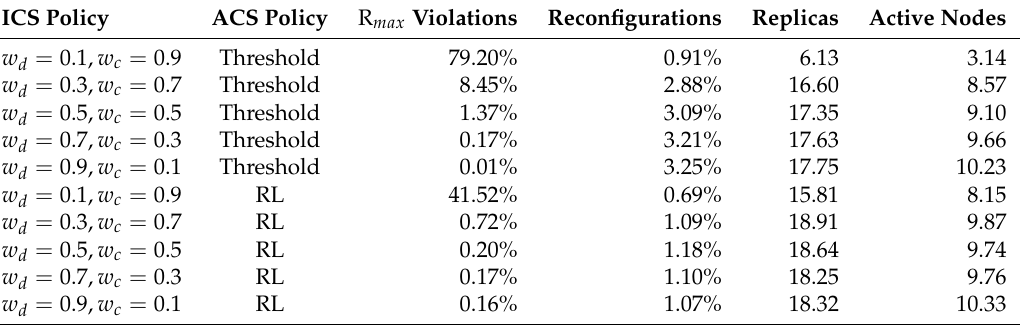
Table 2. Results with different objectives for our RL-based ICS policy. We report the percentage of time in which the target response time R max is violated, the percentage of time in which the ACS decides to reconfigure the application, the average number of operator replicas, and the average number of used computing